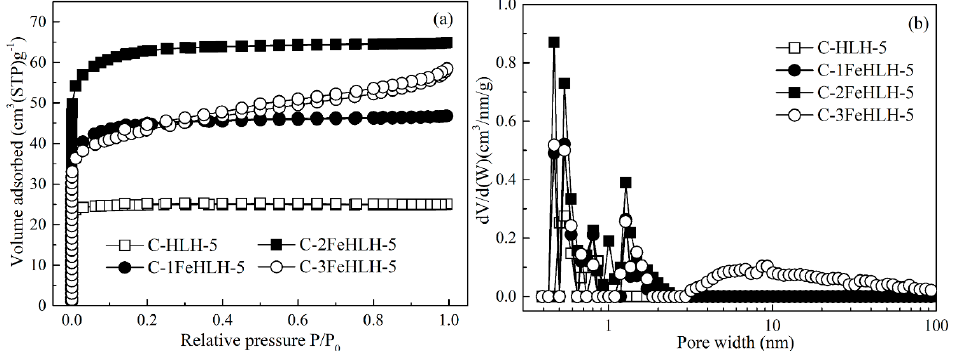
Figure 5. ( a ) N 2 adsorption isotherms and ( b ) pore-size distributions of di ff erent chars with and / or without the additives produced by pyrolysis.